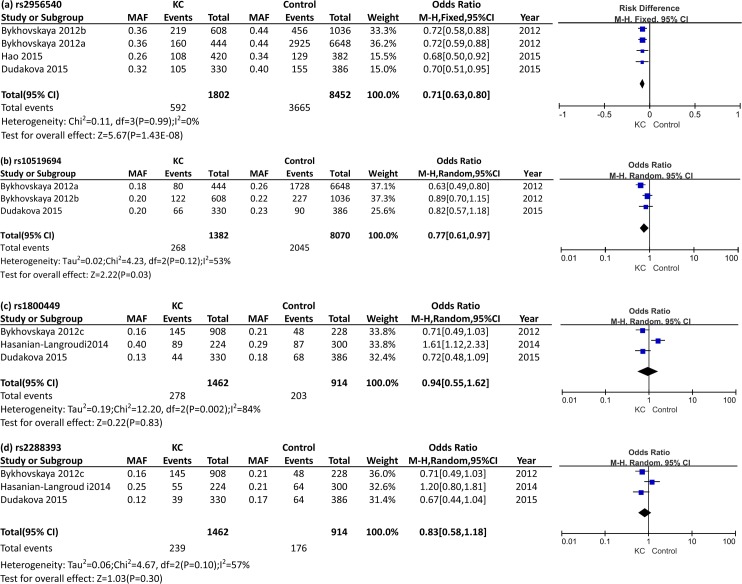
Forest plot of LOX allelic model: (a) LOX rs2956540; (b) LOX rs10519694; (c) LOX rs1800449; (d) LOX rs2288393.Events indicated the minor allele count of each SNP; MAF indicated the minor allele frequency. Squares indicated the study-specific odds ratio (OR). The size of the box was proportional to the weight of the study. Horizontal lines showed 95% confidence interval (CI). A diamond indicated the summary OR with its corresponding 95% CI.